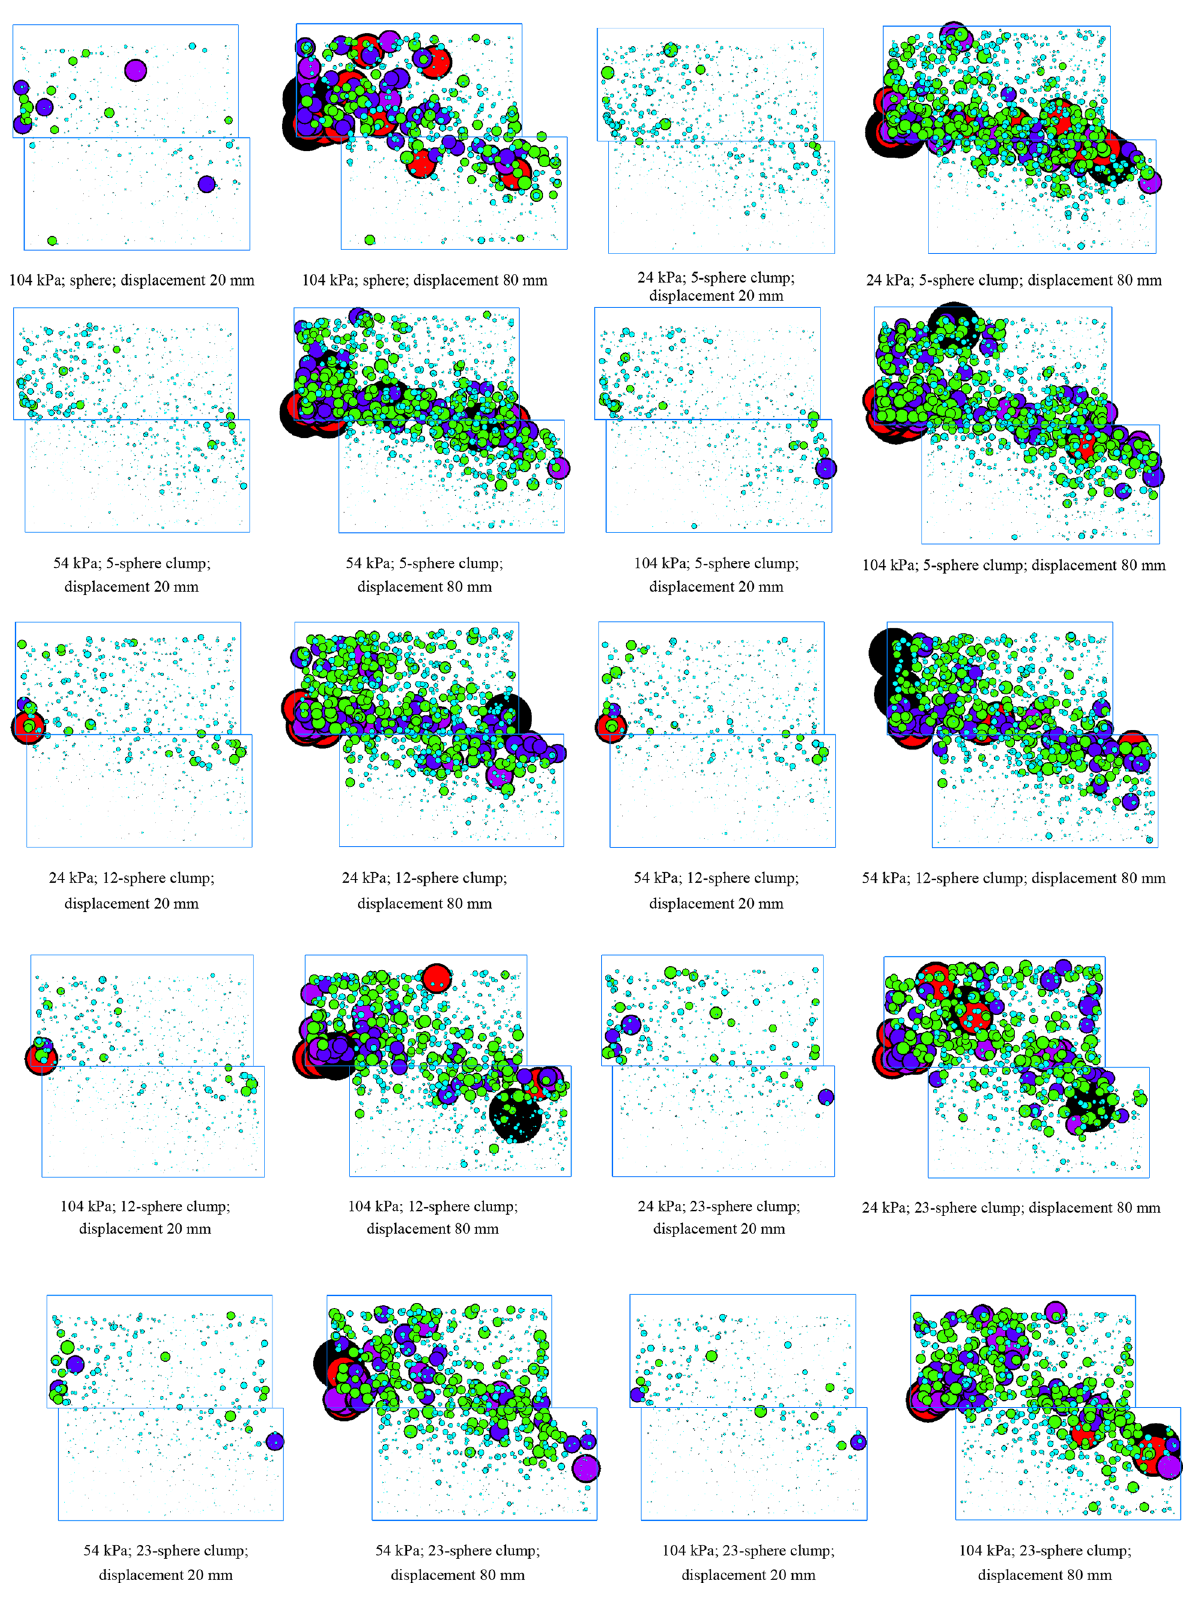
Fig. 16 Particle rotation illustration of the DST